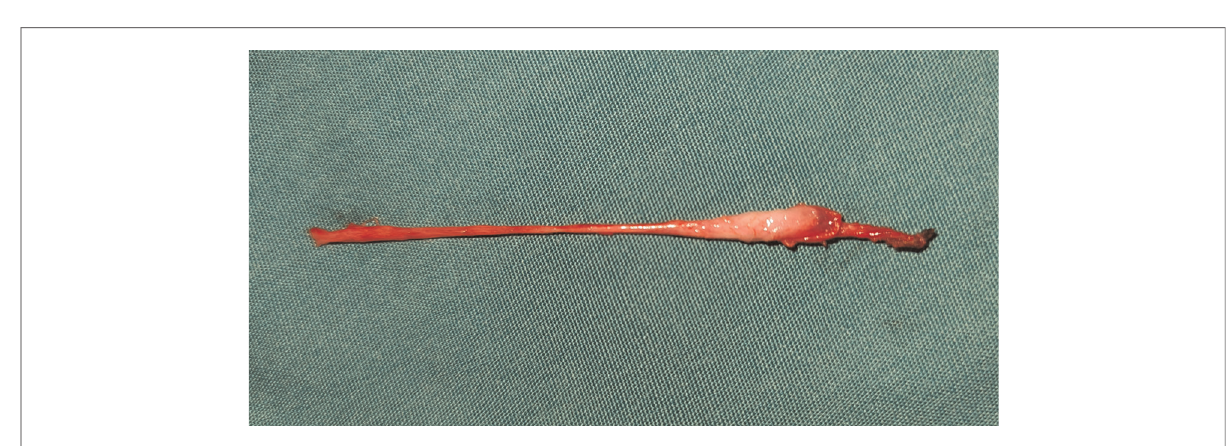
FIGURE 5 A testicular nubbin that was removed by laparoscopy, with the spermatic vessels and gubernaculum